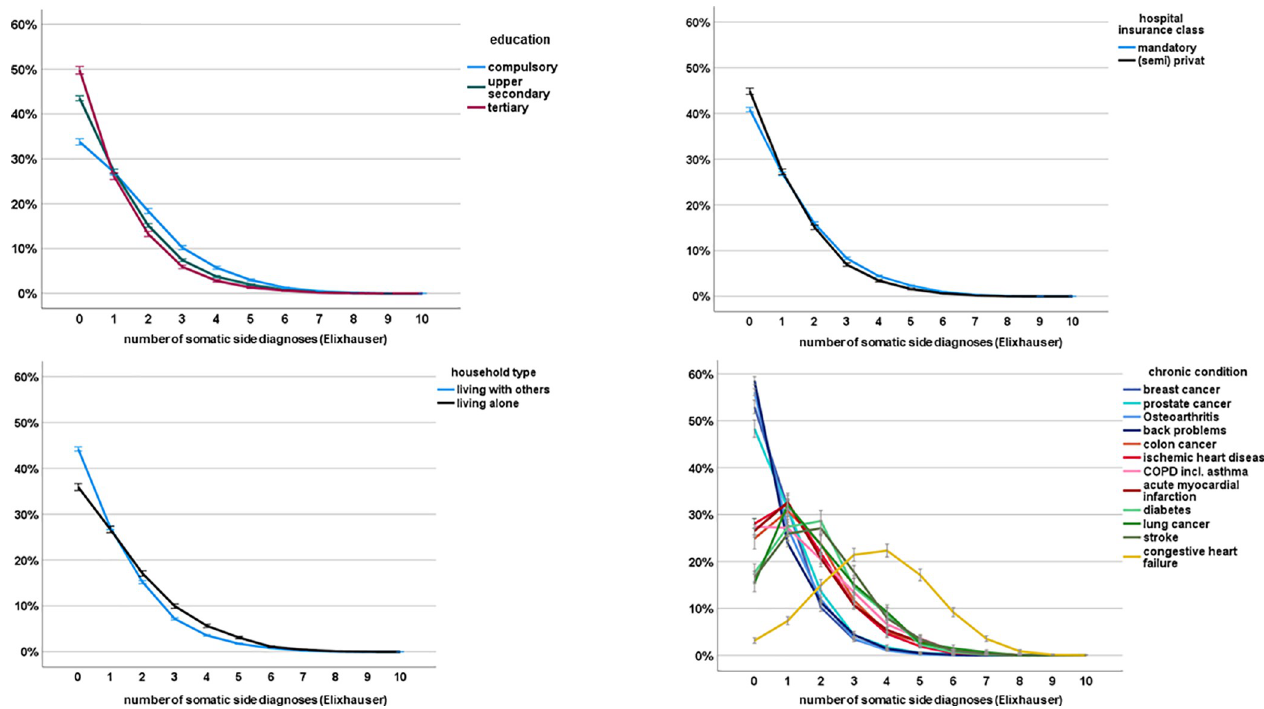
Fig 3. Top. Distribution (%) of number of somatic side diagnoses (Elixhauser) by educational attainment (left) and household type (right). Bottom. Distribution (%) of number of somatic side diagnoses (Elixhauser) by hospital insurance type (left) and chronic condition (right).